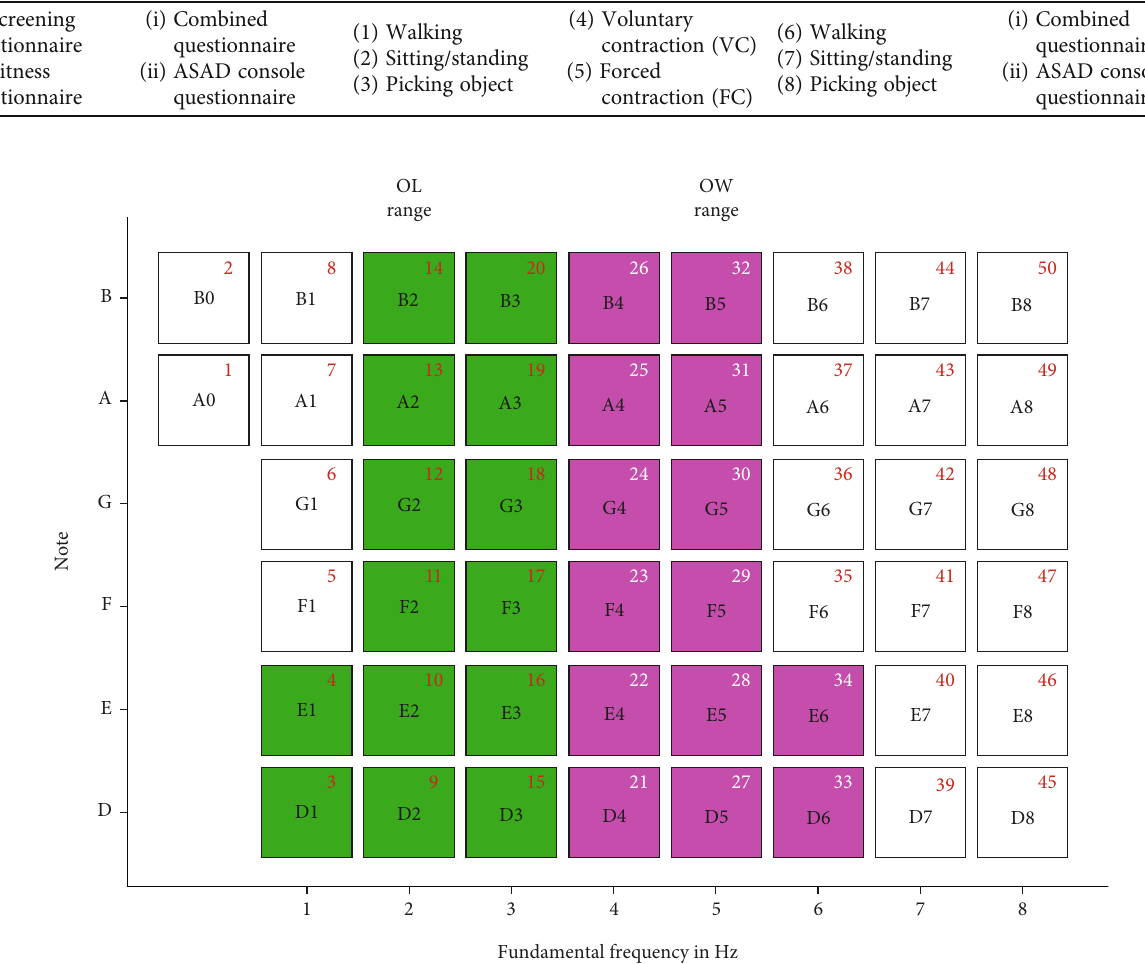
Figure 6: ASAD console heat map of the most used keys, where the balloons with the letter (A) represent mean results before the fatigue test, balloons with letter (B) represent mean results after the fatigue test, and the colors indicate the degree of signi fi cance; white balloons are not signi fi cant, blue were mildly signi fi cant, and yellow balloons were signi fi